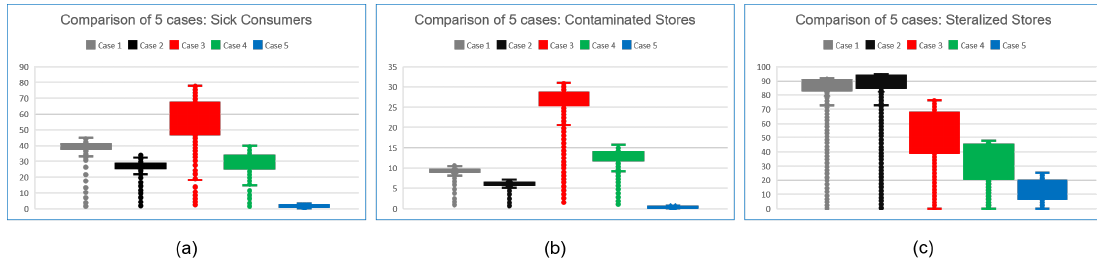
Figure 10. Simulation Results: Average values (with standard deviations) based on 100 runs for: ( a ) sick consumers, ( b ) contaminated stores, ( c ) sterilized